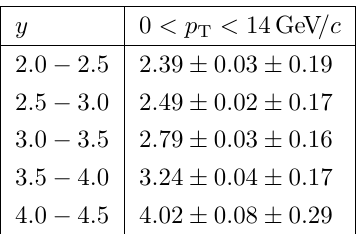
Table 17 . Cross-section ratios between 13 TeV and 5 TeV measurements for nonprompt J/ψ mesons as a function of y with p T < 14 GeV/ c . The first uncertainty is statistical and the second is